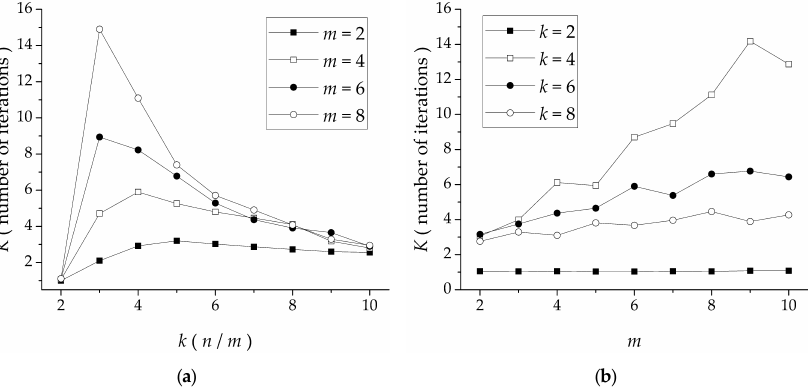
Figure 10. IBF number of iterations for: ( a ) k = 2–10 and ( b ) m = 2–10.